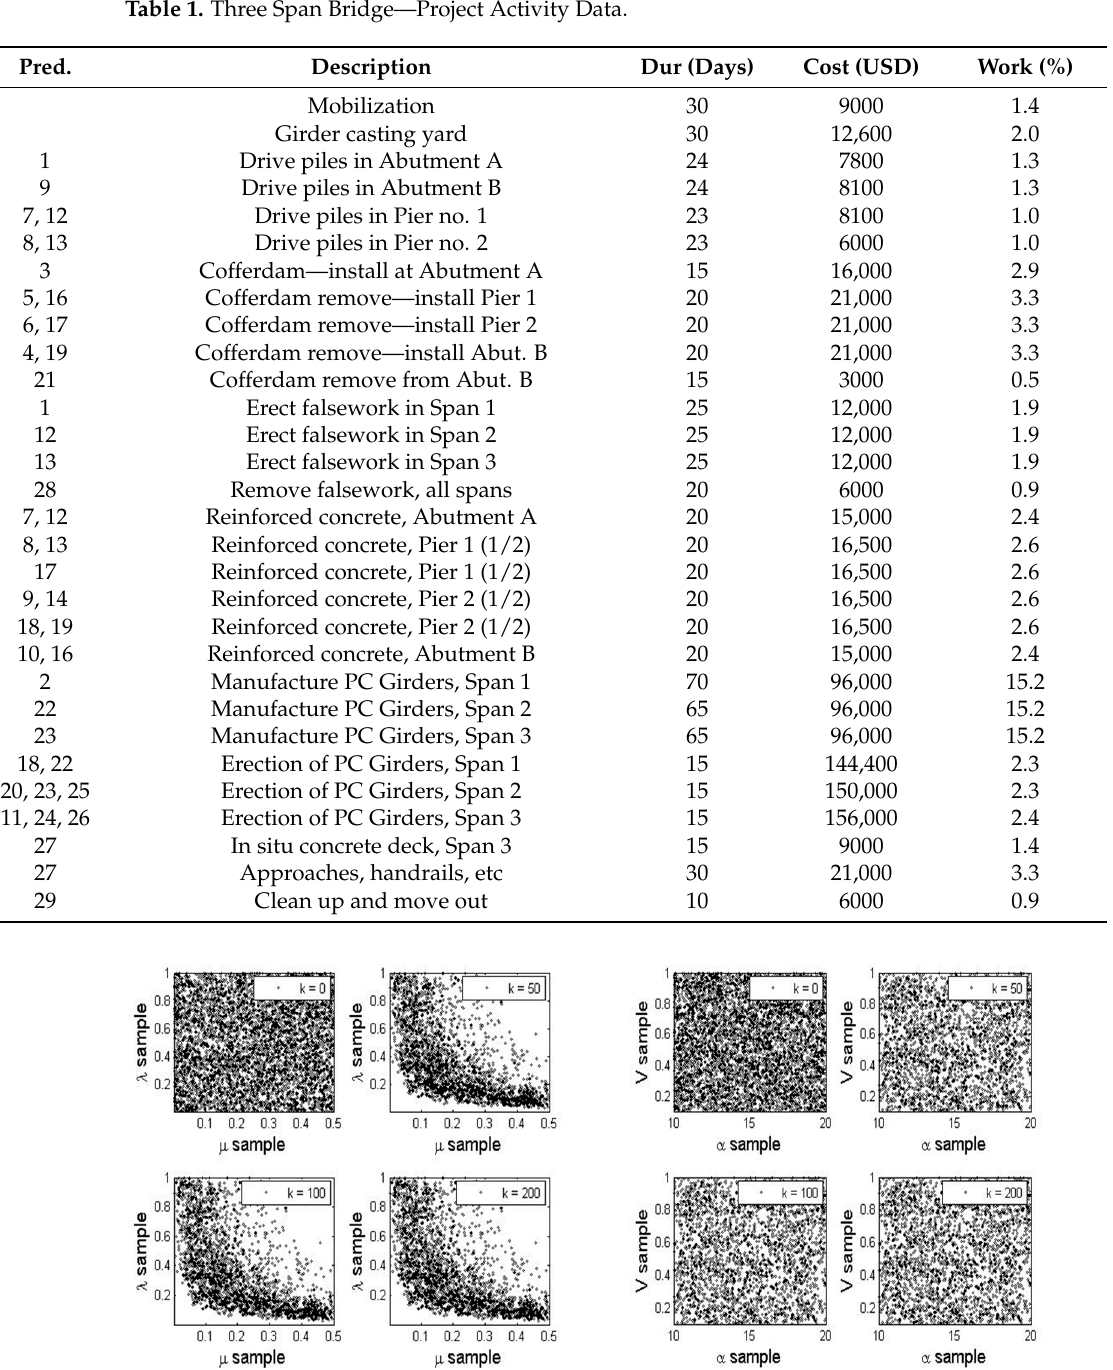
Table 1. Three Span Bridge—Project Activity Data.